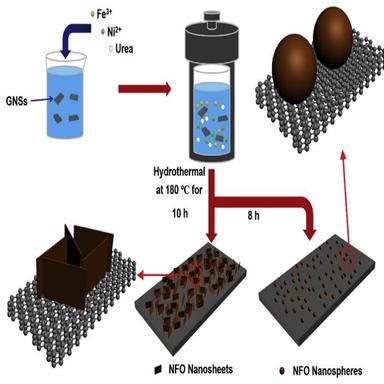
(a) FESEM image of NFO/GNSs-8; (b,c) low magnification microscopic image and (d) high magnification microscopic image of NFO/GNSs-10; (e) elemental mapping of NFO/ GNSs-10.